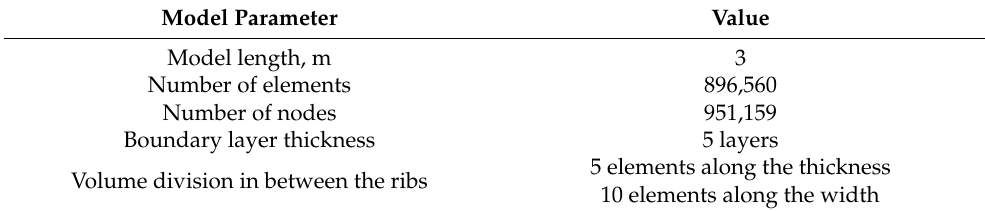
Table 3. Parameters of the numerical meshes used for the calculations of the frictional pressure losses.